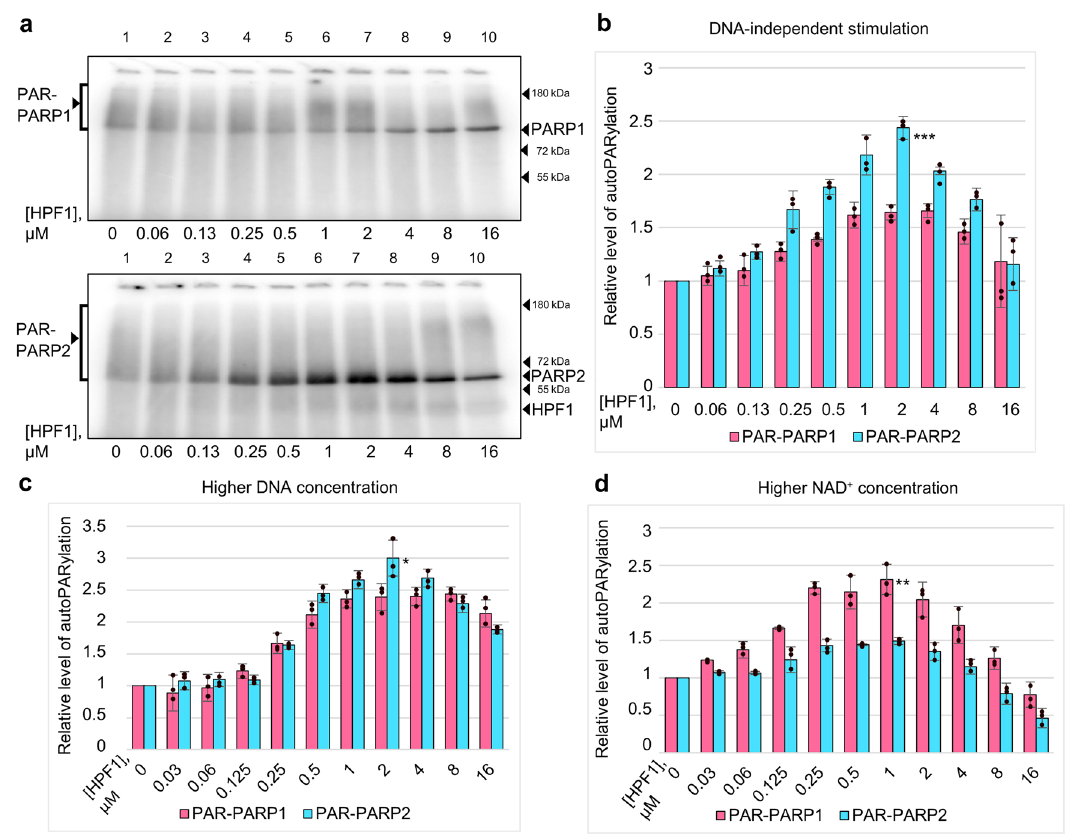
Fig. 3 HPF1 stimulates PARP1- and PARP2-catalyzed autoPARylation in the absence of DNA and at higher DNA and NAD + concentrations. a Autoradiograms show covalent binding of 32 P-labelled ADP-ribose to PARP1 and PARP2 after incubation of PARPs (500 nM) with [ 32 P]NAD + (1 μ M) in the absence (sample 1) and presence of increasing HPF1 concentrations (from 60 nM to 16 μ M, samples 2 ‒ 10) and further separation of products in 20% SDS-PAG. b Histograms present relative labelling levels (the mean ± SD of three independent measurements and individual data points) of PARP1 and PARP2 determined by normalization of the ADP-ribose amounts covalently bound to the given protein in the presence of HPF1 to the respective amount in its absence. c , d Histograms present relative labelling levels (the mean ± SD of three independent measurements and individual data points) of PARP1 and PARP2 under varied reaction conditions: 2 μ M DNA and 1 μ M [ 32 P]NAD + ( c ); 0.25 μ M DNA and 10 μ M [ 32 P]NAD + ( d ). Original autoradiograms are presented in Supplementary Fig. 3. Statistically signi fi cant differences between PARP1 and PARP2 in the effects detected at the optimal HPF1 concentration are marked p < 0.05 (*), p < 0.01 (**), p < 0.001